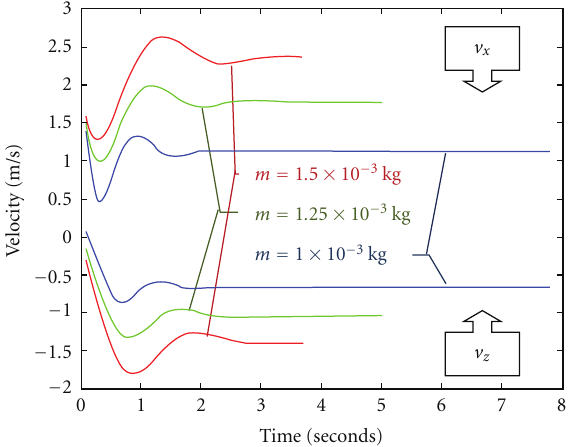
Figure 5: Dragonfly gliding straight—changing the weight. Velocity versus time.